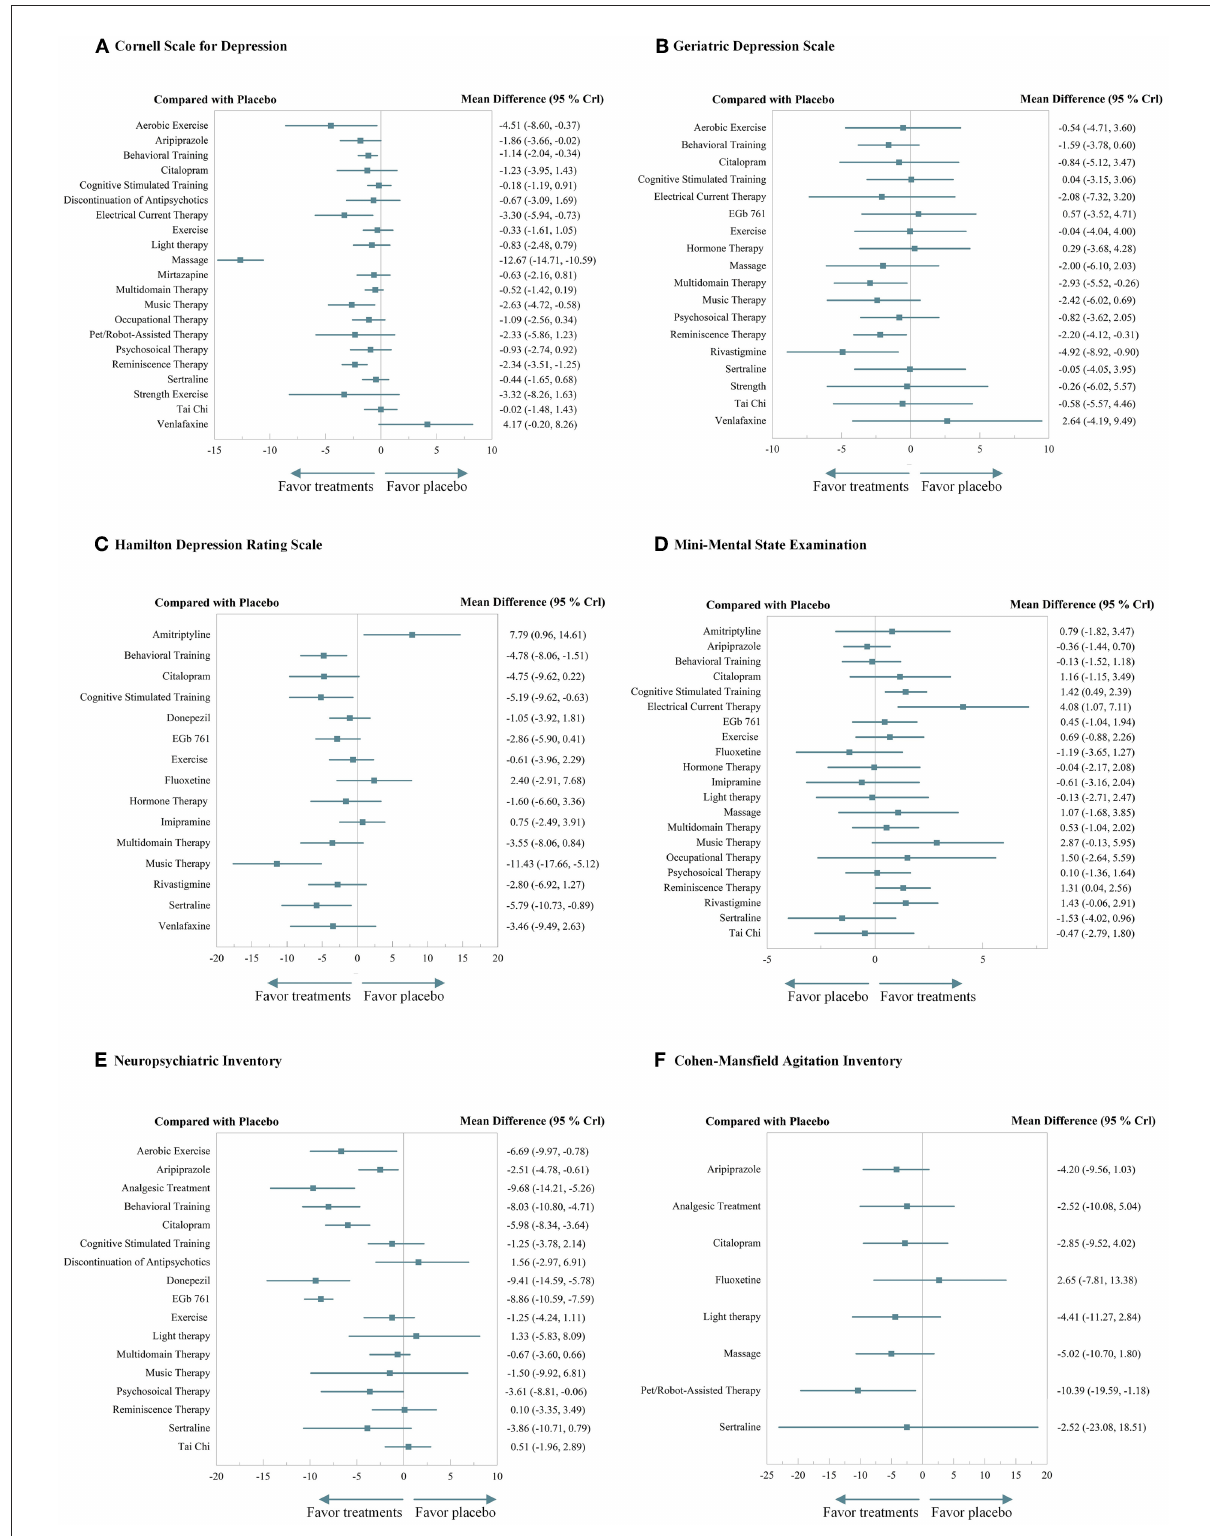
FIGURE3 A forest plot of efficacy. (A) Cornell Scale for Depression. (B) Geriatric Depression Scale. (C) Hamilton Depression Rating Scale. (D) Mini-Mental State Examination. (E) Neuropsychiatric Inventory. (F) Cohen–Mansfeld Agitation